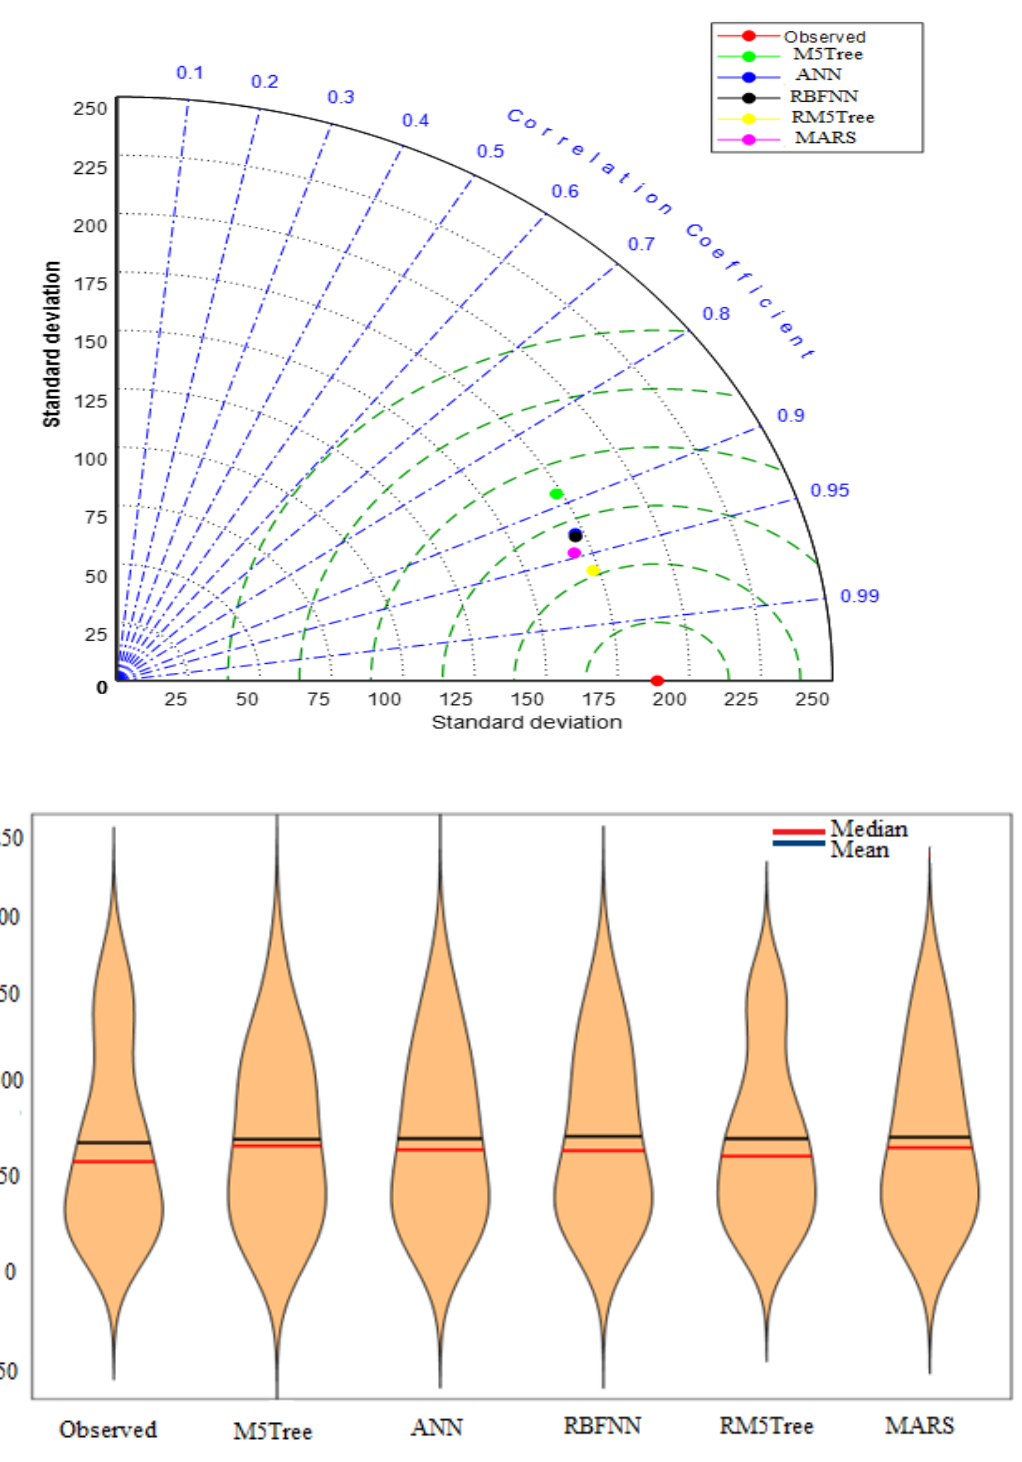
Figure 11. Taylor and violin diagrams by different models in the test period—Station 2 estimation using upstream data.